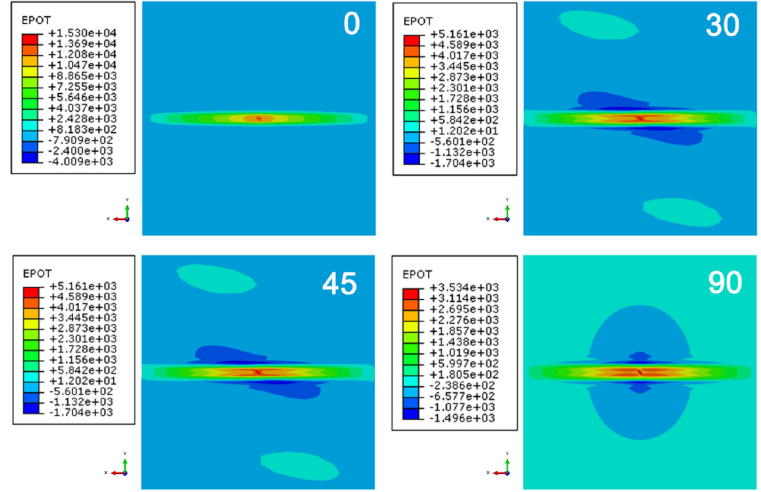
Figure 11. Potential distributions at the surface of the composites with different layup sequences.